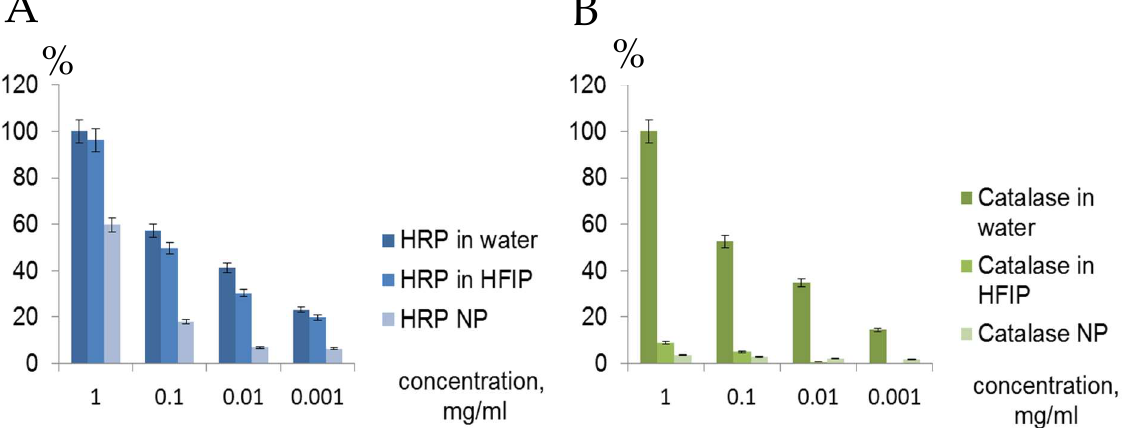
Figure 7. Comparison of enzymatic activity of HRP ( A ) and catalase ( B ) in solutions in water and fluoroalcohol, as well as in ENP.